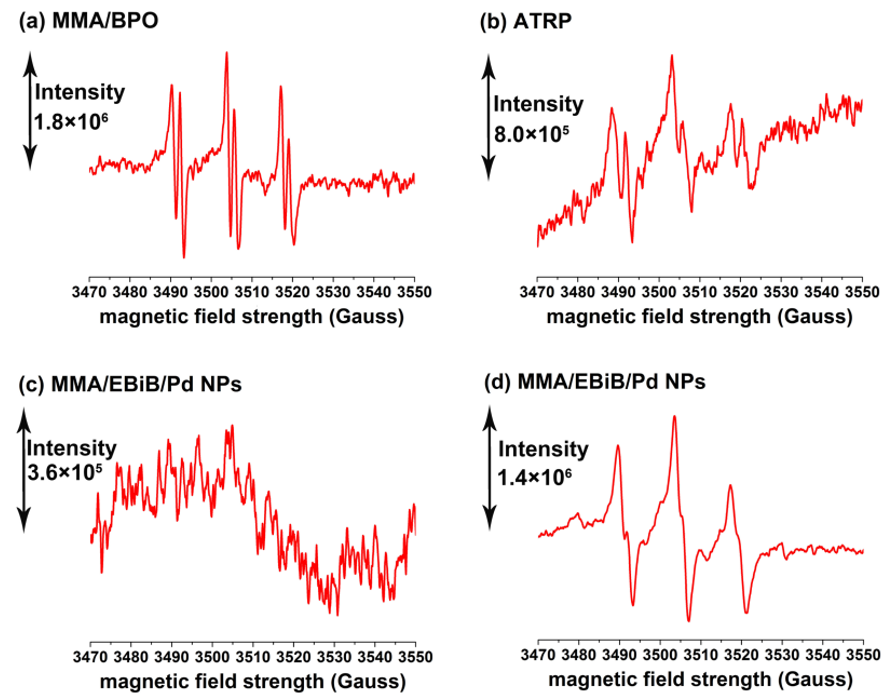
Figure 4. ESR spectra acquired in a free radical polymerization of MMA ( a ), atom transfer radical polymerization (ATRP) of MMA ( b ), EBiB / Pd NP-initiated polymerizations of MMA ( c , d ). Reaction conditions: [MMA] = 9.4 mol / L, [PBN] = 0.075 mol / L, temperature = 70 ◦ C; all spectra acquired at reaction time = 40 min; ( a ) [MMA] / [BPO initiator] = 1.72 × 10 3 :1; ( b ) [MMA] / [initiator] / [copper catalyst] = 1.72 × 10 3 :1:2.5; ( c ) [MMA] / [EBiB] / [Pd NP] = 1.72 × 10 3 :1:0.1; ( d ) [MMA] / [EBiB] / [Pd NP] = 1.72 × 10 3